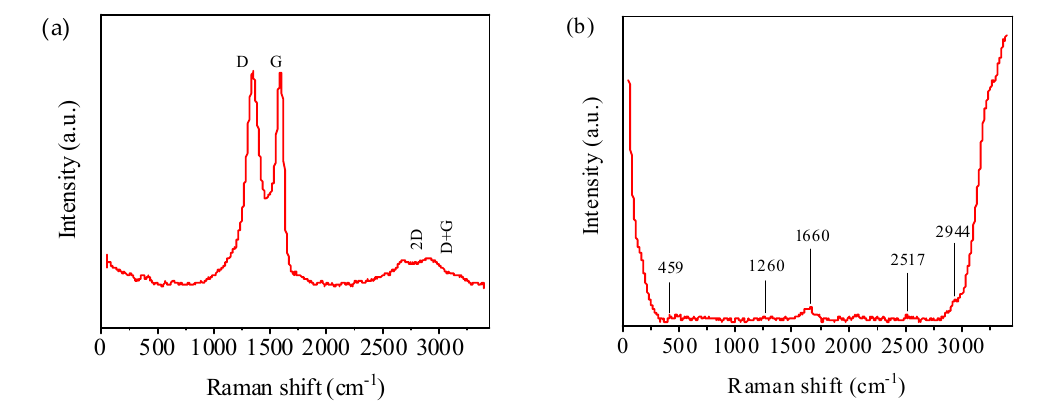
Figure 5. Raman spectra of ( a ) GO and ( b ) EA.